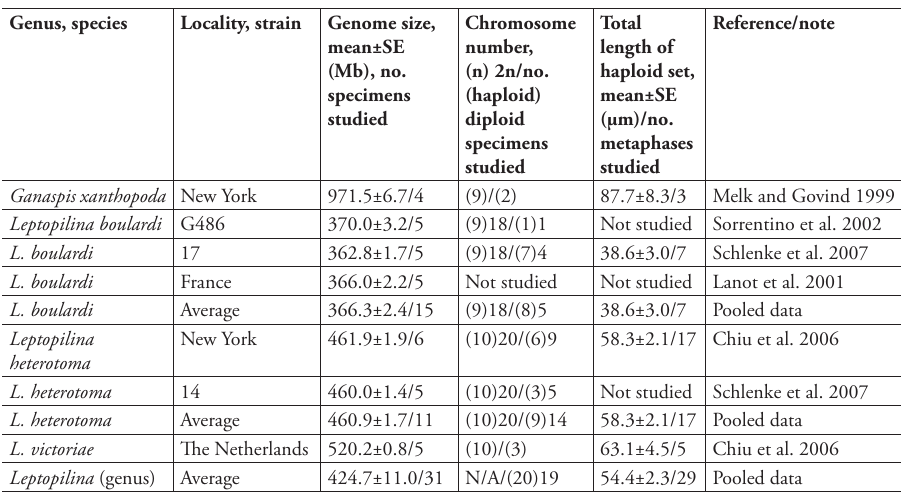
table 1. Origins, genome sizes, and gross karyotypic data of Drosophila parasitoids. Genome size of wasp species correlates with total chromosomal length deduced from karyotypic analysis. The total length of the haploid G. xanthopoda chromosome set differs from both L. boulardi and L. heterotoma at p<0.001, and from L. victoriae at p <0.05; L. boulardi differs from both L. heterotoma and L. victoriae at p<0.001 (T-tests for independent